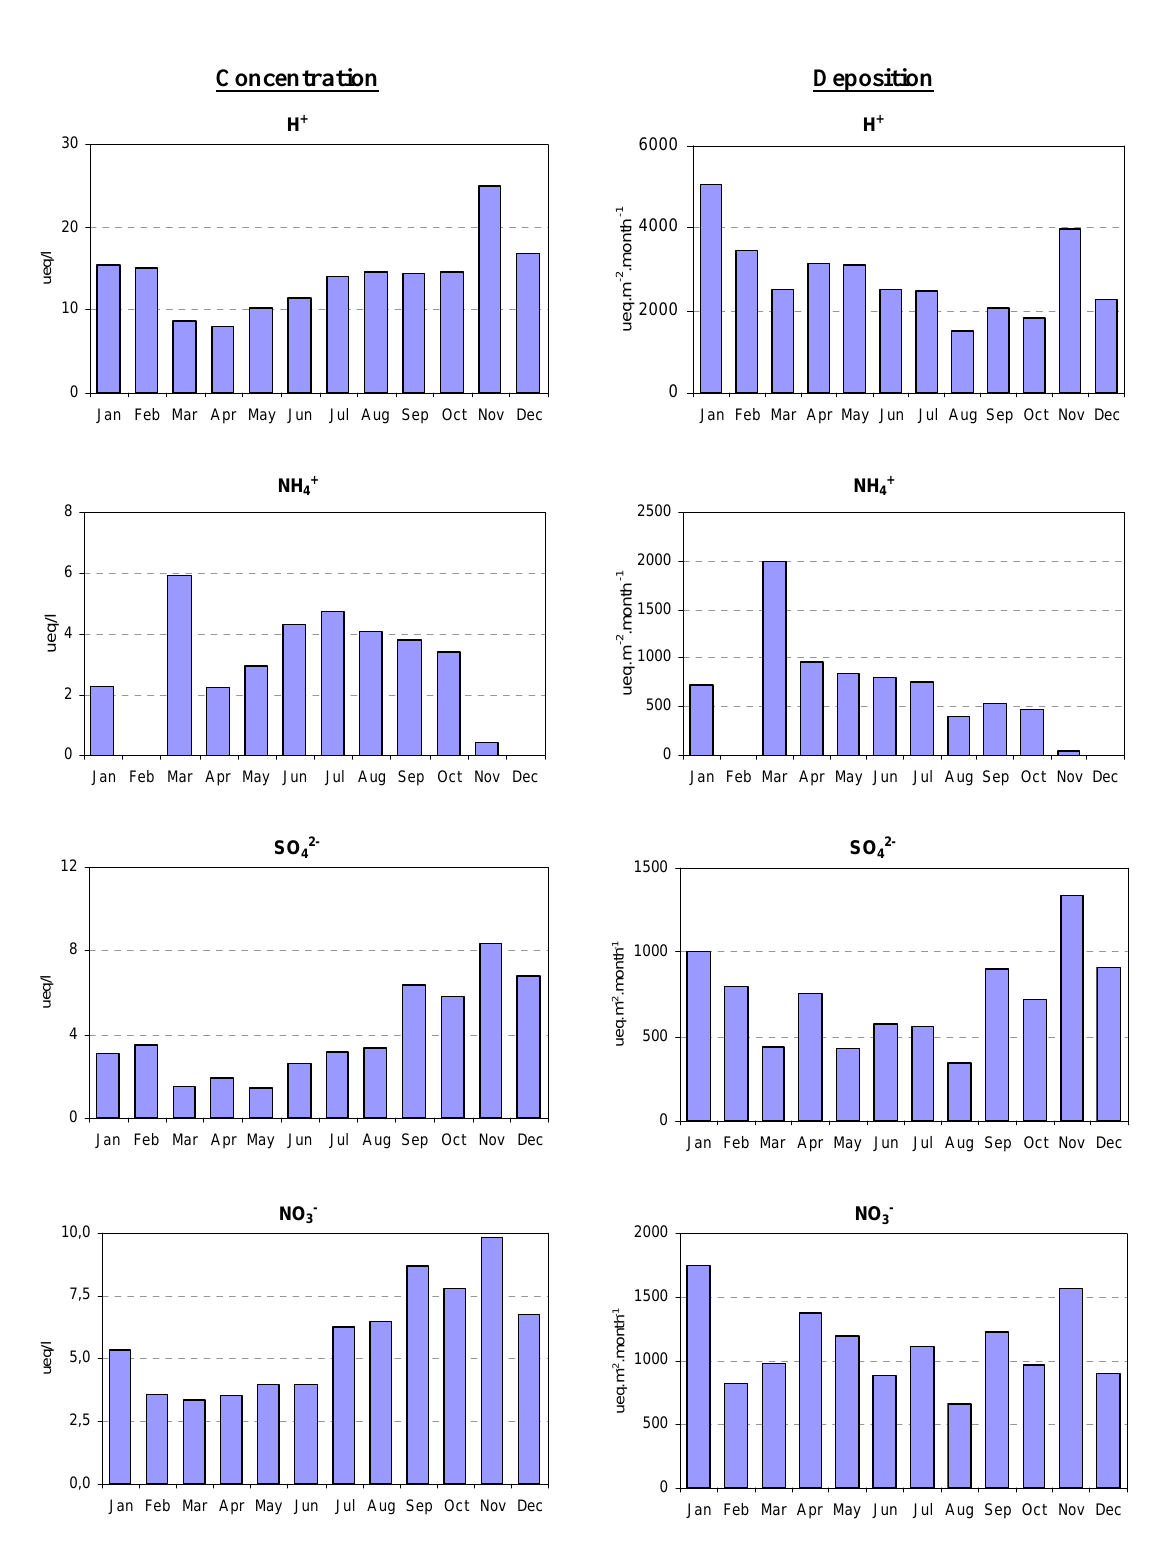
Fig. 7. Monthly means of observed ionic VWM concentration (left) and deposition (right) in